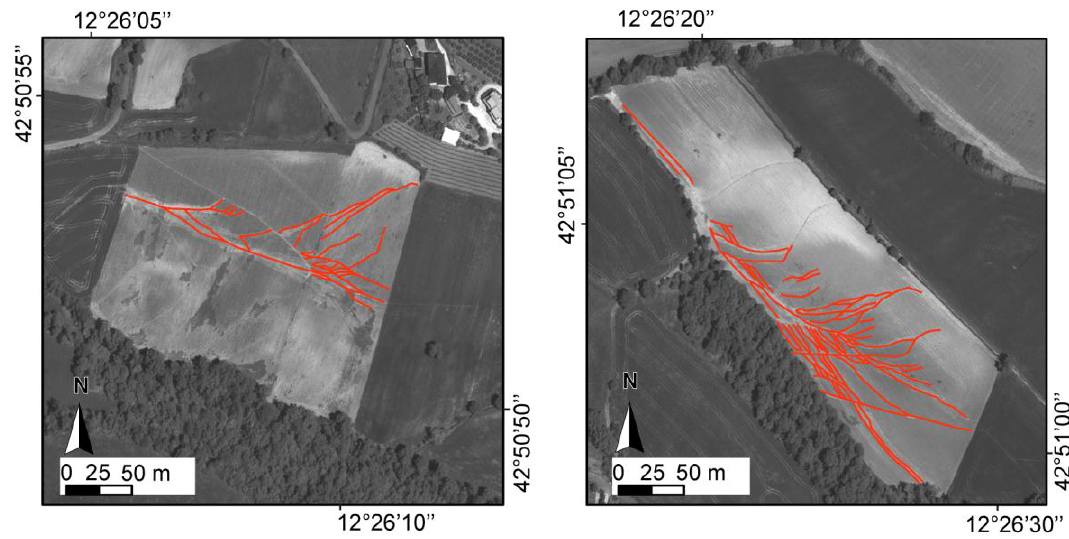
Figure 10. Examples of rills and ephemeral gullies that were mapped on the satellite images. The average channel length is 26.5 m (σ = 26.2 m), and the total length of the channels is 1.4 × 10 4 m. We measured the top widths and depths of a subset of 55 channels segments (see Table 2) of the SMC subset (14 rills and 41 gullies). Rills and gullies are classified based on the cross-sectional